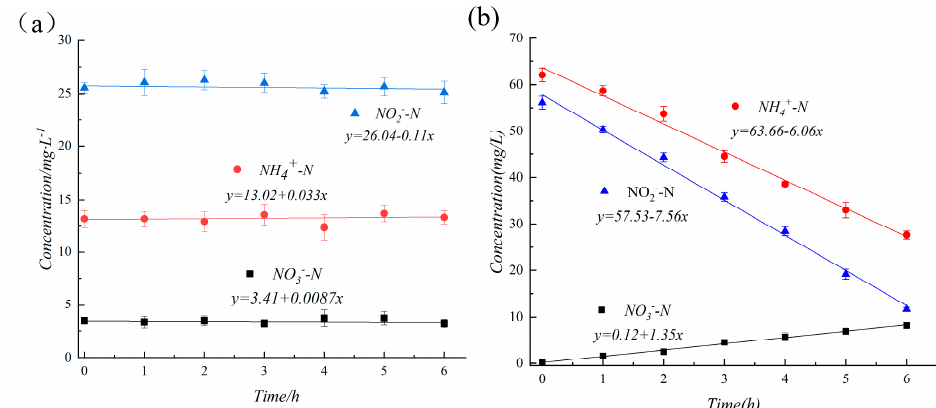
Figure 6. Variations of NO 3 − -N, NO 2 − -N and NH 4+ -N in the system under no DO conditions: ( a ) The S 0 -SADN operation stage; ( b ) The ANAMMOX start-up stage.